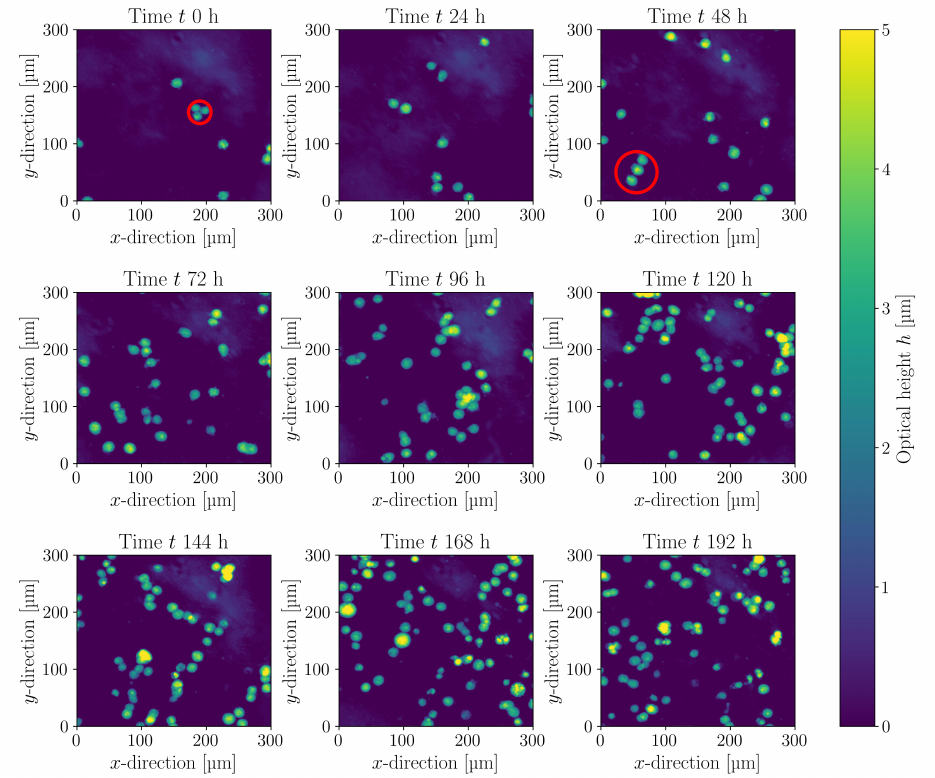
Figure 11. Examples from the evaluation of the optical height at different times of cultivation in the Minifors 2 bioreactor ( N = 180rpm, V = 4L). The optical height was determined online using the Ovizio iLine F analyzer. Marked in red are the two extreme forms of a cell cluster with three cells ( t = 0h close-packing and t = 48h cell